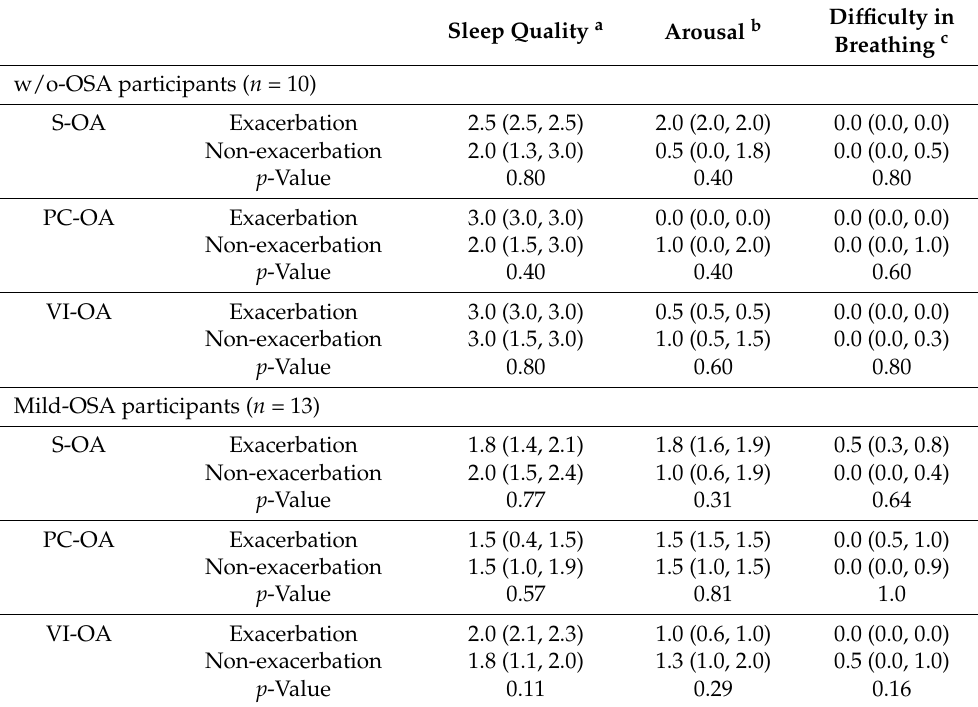
Table 4. Sleep satisfaction while wearing the three types of